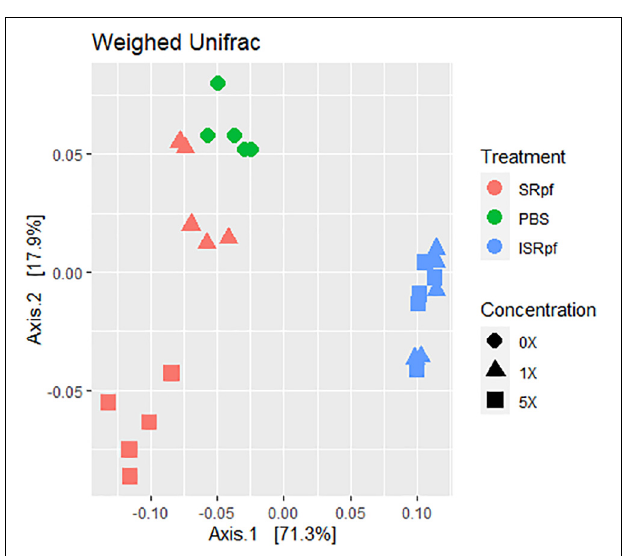
FIGURE 3 | Weighted UniFrac distance ordination method for MDS showing distance between different treatments and concentration levels.